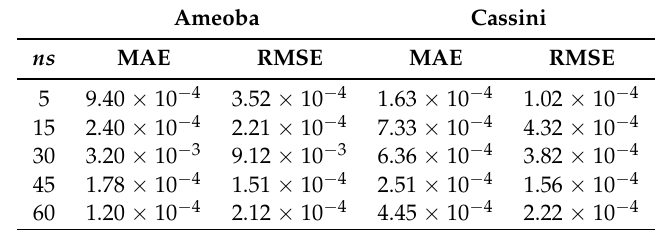
Table 5. MAE and RMSE for Ameoba and Cassini-shaped domains at t = 1 with different stencil sizes.